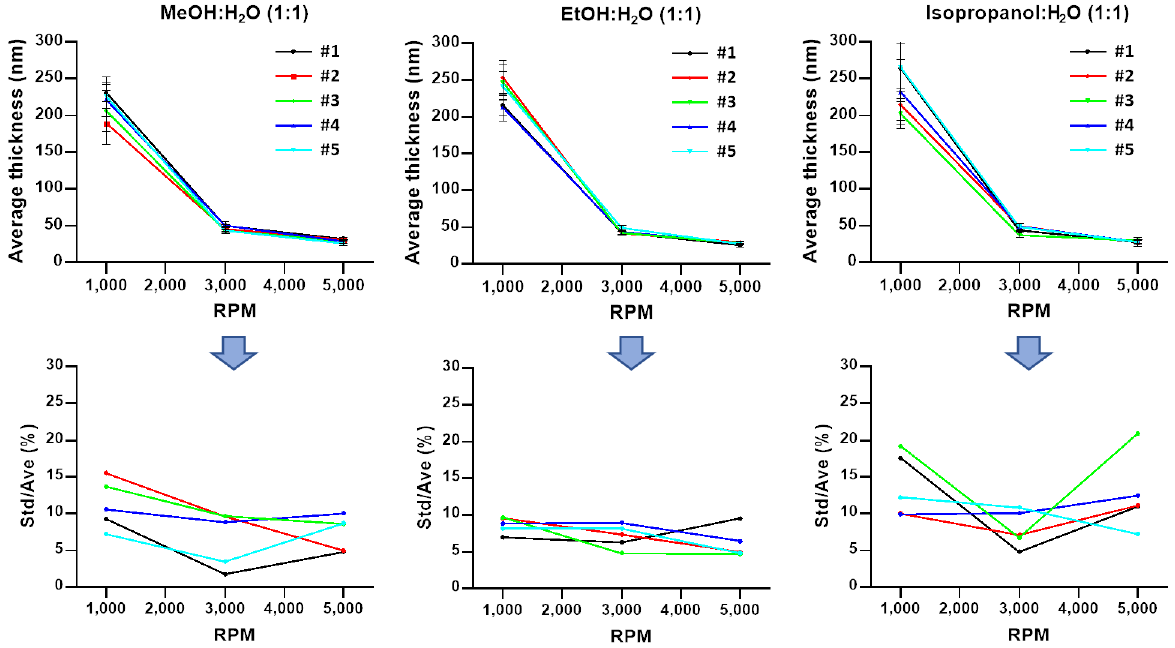
Figure 4. A total of 5 data sets of average thickness and standard deviation from 5 × 5 measurements of 1:1 MeOH/H 2 O, 1:1 EtOH/H 2 O, and 1:1 isopropanol/H 2 O DNA solution films. An amount of 2 mL of aqueous DNA at 8 mg/mL (0.8 wt.%) diluted with 2 mL of methanol, ethanol, and isopropanol, respectively.